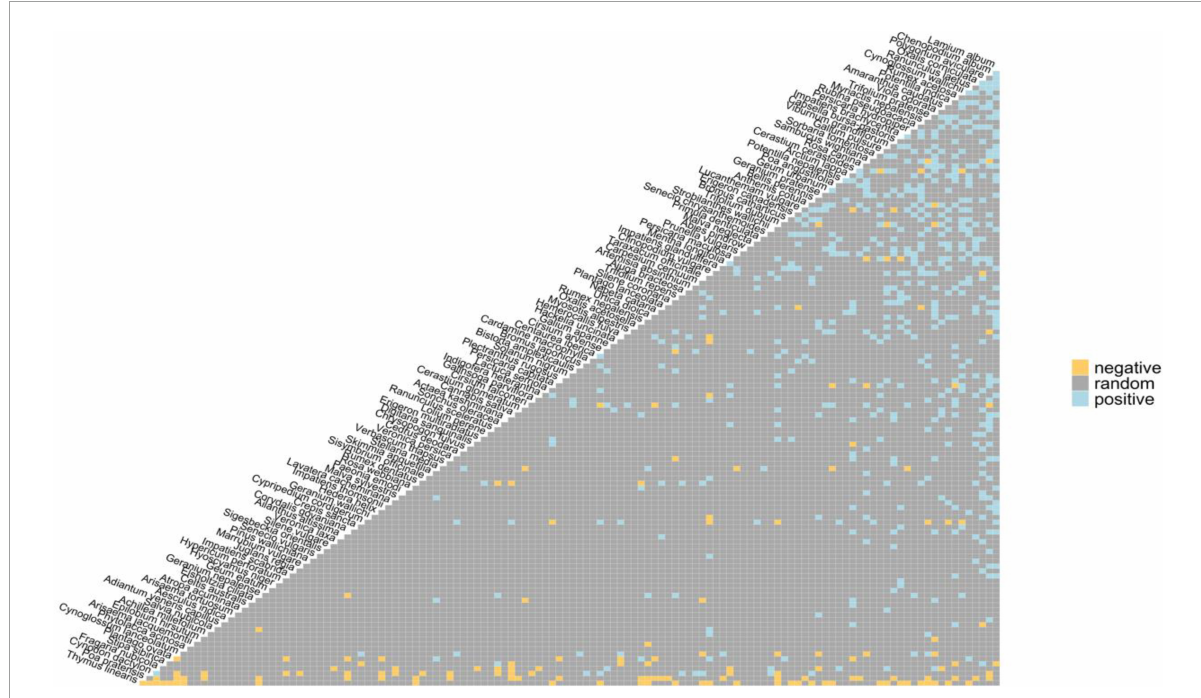
FIGURE4 Heat map (co-occurrence plot) portraying the significant random negative and positive species relationships.